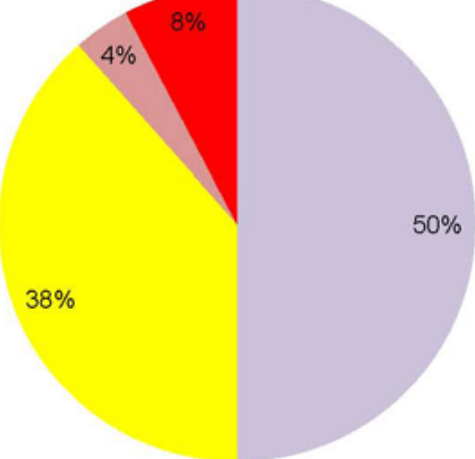
Figure 12: Activity types (by overarching group) predominantly concerned with mediation and the mechanisms used (shown as